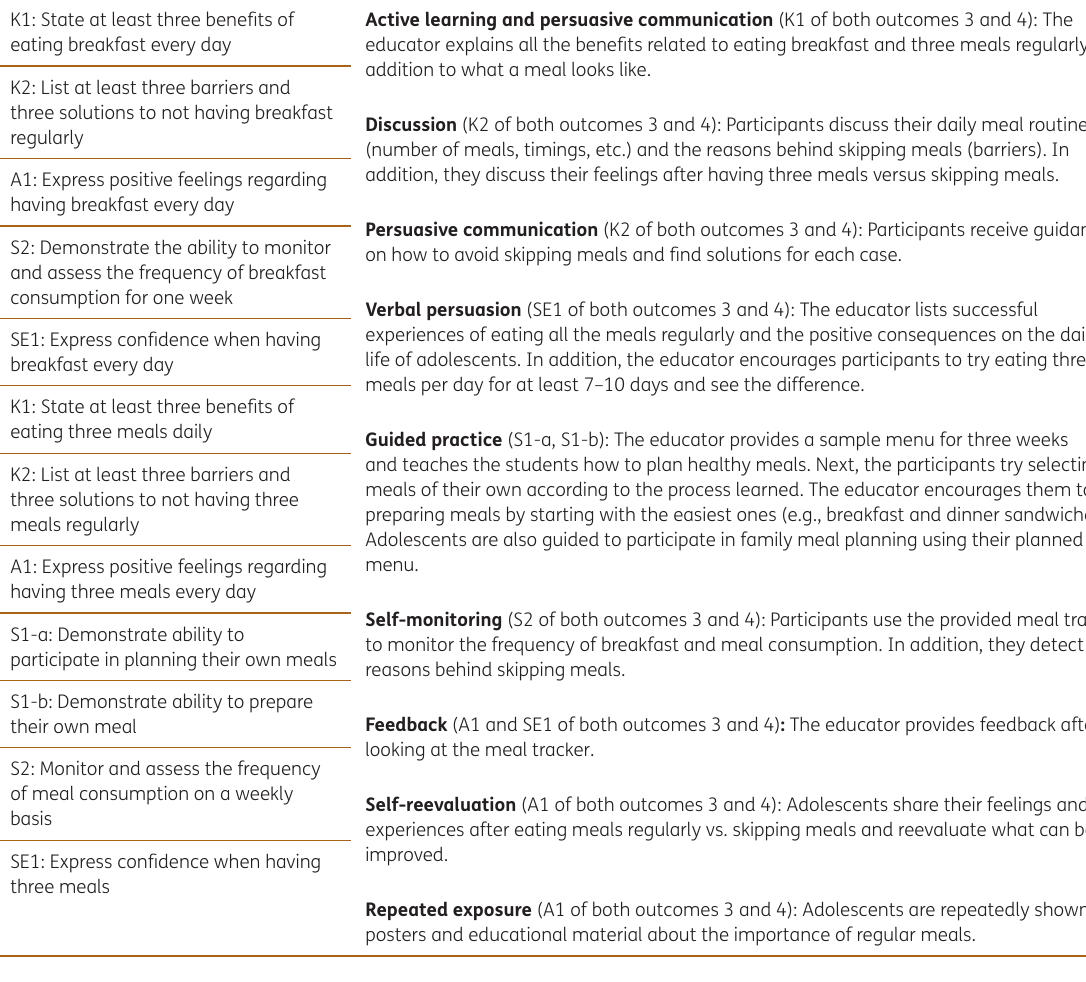
Table 2 Example of methods and applications used for selected change objectives related to outcomes 3 and 4 (see Table S1-C – Supplementary file